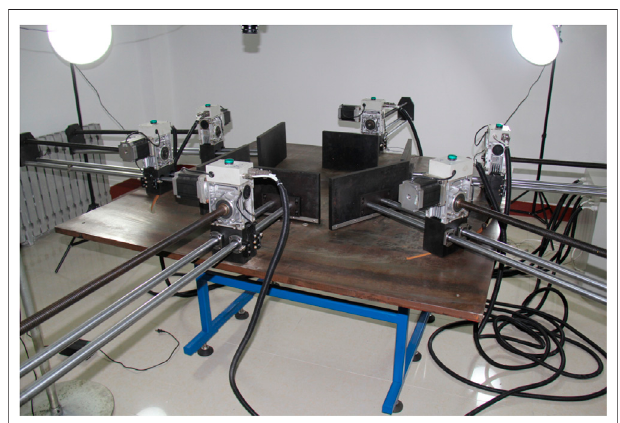
FIGURE 10 | Physical simulation experimental